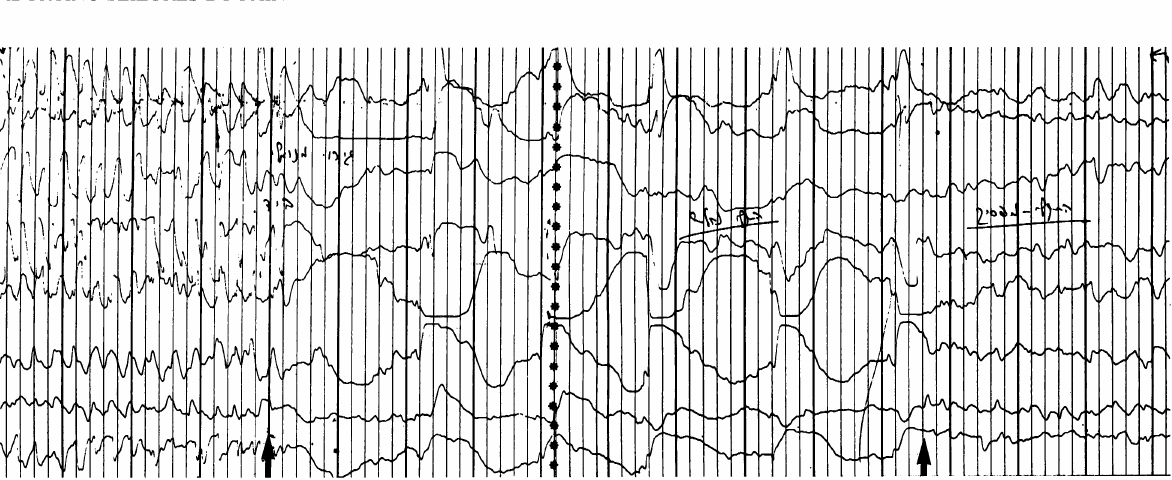
FIG. 2. Case 2 (S.R.). Dorsiflexion begun at left arrow and maintained until seizure stops (right arrow). Vertical column (asterisks) indicates discontinuity in EEG record. See text for details.